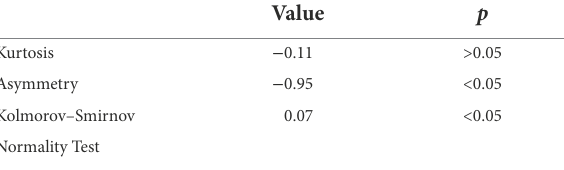
TABLE 8 Characteristics of the distribution of total scores of the